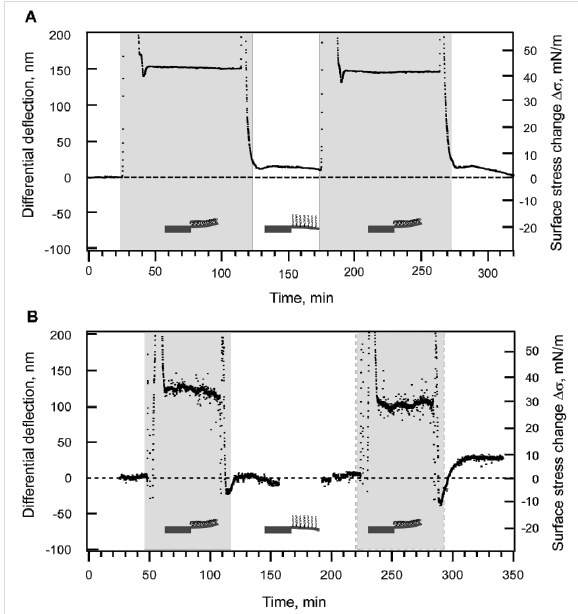
Figure 7: Collapse and restretching of the tethered mPEG–SH-layer observed when switching from good (PBS) to poor solvent conditions, particularly in 20% (A) and 10% (B) 2-propanol in PBS. The duration of each poor solvent injection is shaded in gray. (A) As an in situ refer- ence two microcantilevers in the array were blocked with EG 4 –C 11 –SH. (B) As an external reference, a non-functionalized Au-coated microcantilever array was used. The averaged deflection of eight reference cantilevers was subsequently subtracted from the average deflection of eight sensing cantilevers to obtain the differen- tial